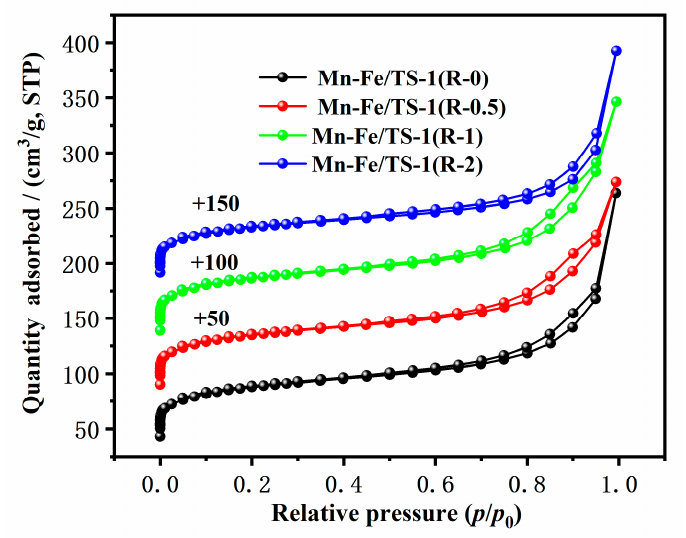
Figure 3. N 2 adsorption–desorption isotherms of Mn–Fe/TS-1(R-0), Mn–Fe/TS-1(R-0.5), Mn–Fe/TS-1(R-1), and Mn–Fe/TS-1(R-2). Table 1. Textural properties and elemental compositions of catalysts.